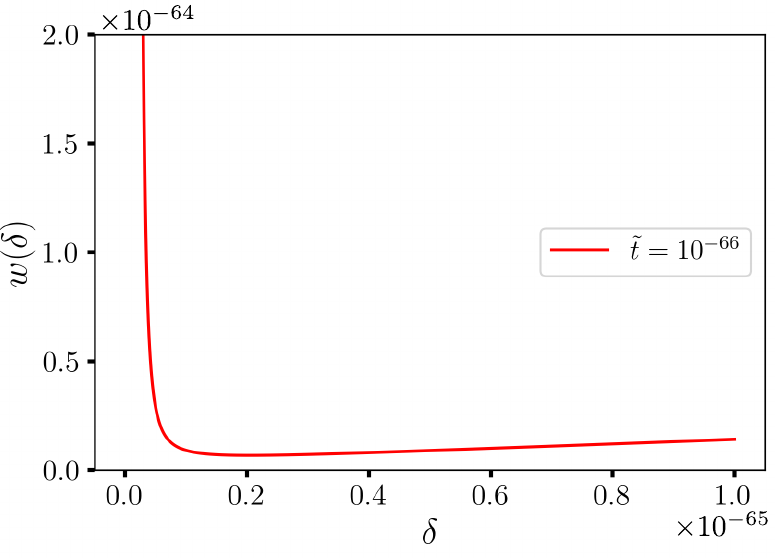
Figure 4. Plot of the semiclassically corrected photon geodesic impact parameter relation. The plot shows a bounce as the distance from the critical radius approaches the semiclassical length scale of ˜ t ∼ 10 − 66